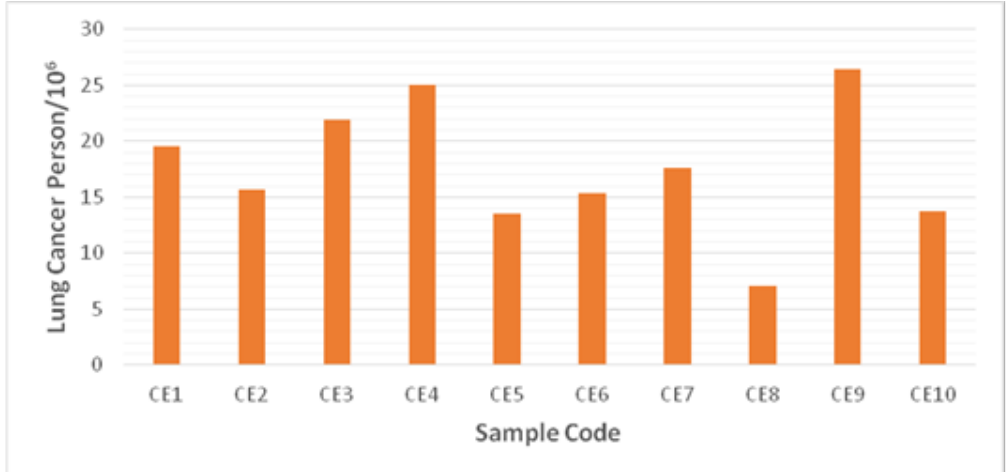
Figure 5: Lung cancer cases per million people annually for cement samples after